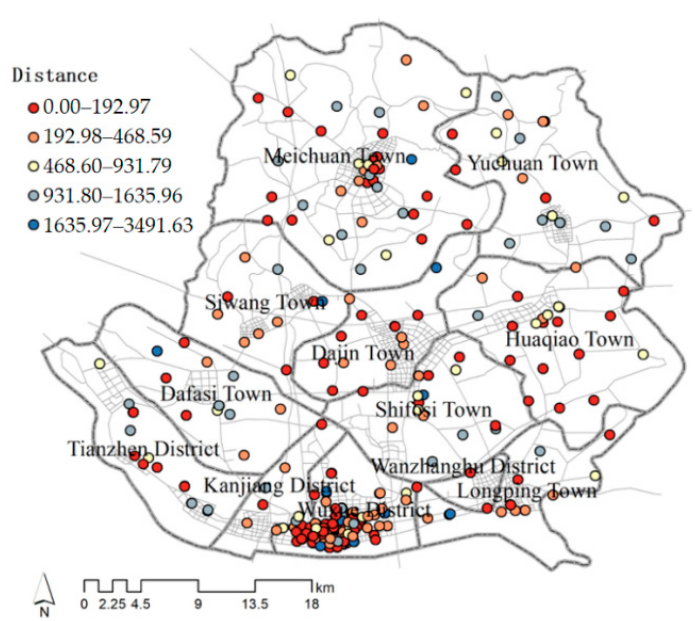
Figure 11. Accessibility analysis based on travel distance.